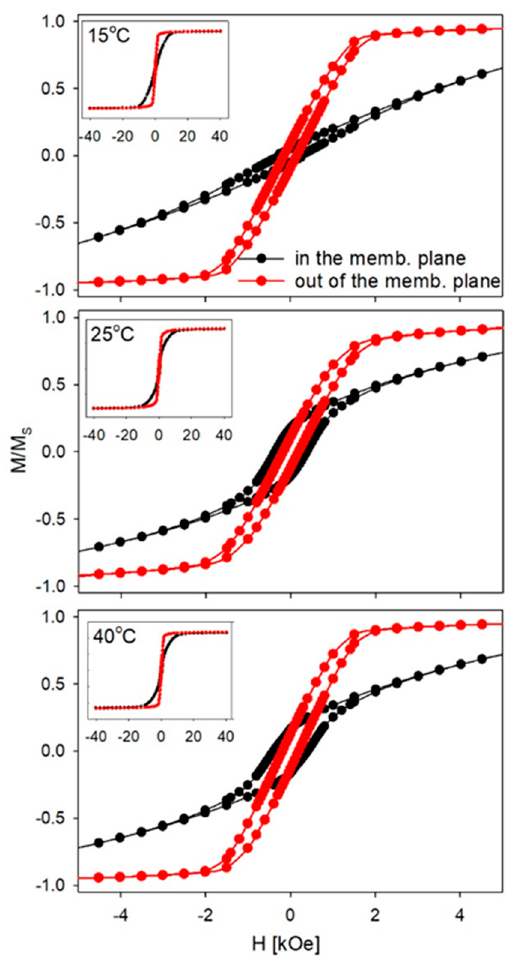
Figure 12. Hysteresis loops measured at room temperature in the membrane plane and out of the membrane plane. The magnetization (M) value was normalized to the saturation magnetization (M S ).